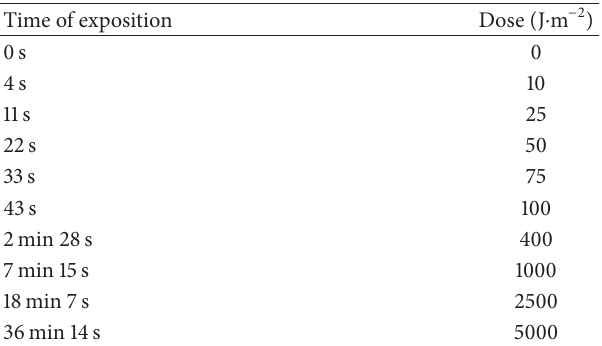
Table 3: Changes in the number of E. coli depending on the surface density of the UV-C radiation dose.